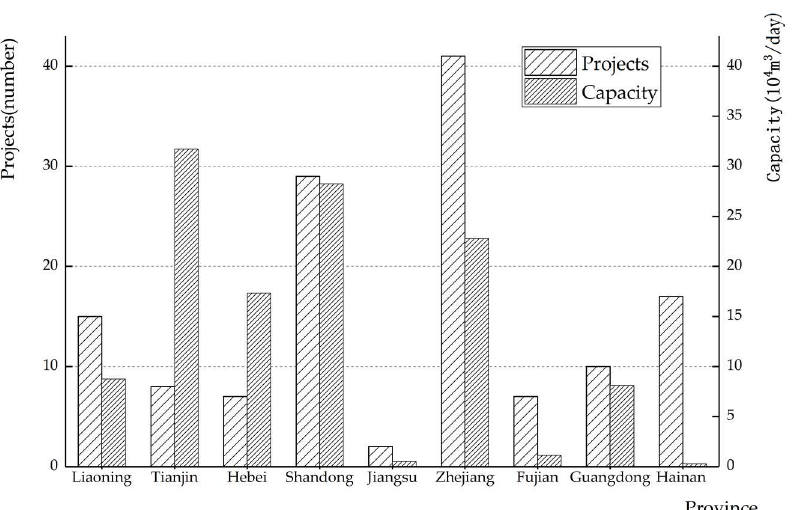
Figure 4. The spatial distribution of seawater desalination capacity and projects in China in 2017.